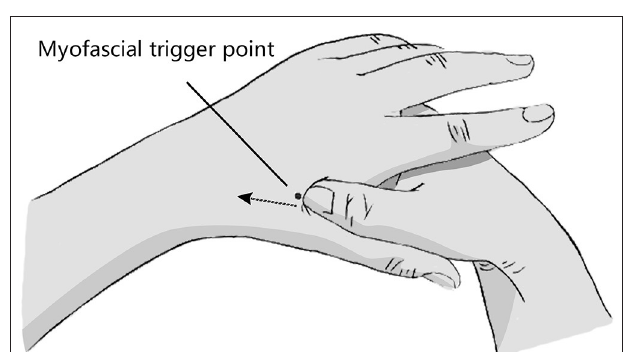
FIGURE 2 | The location of myofascial trigger